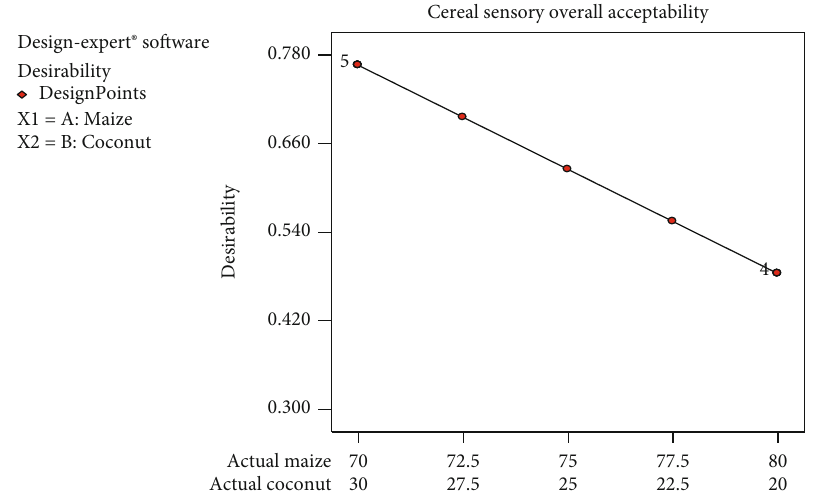
Figure 7: Mean graph for desirability (overall acceptability) of sensory responses on the